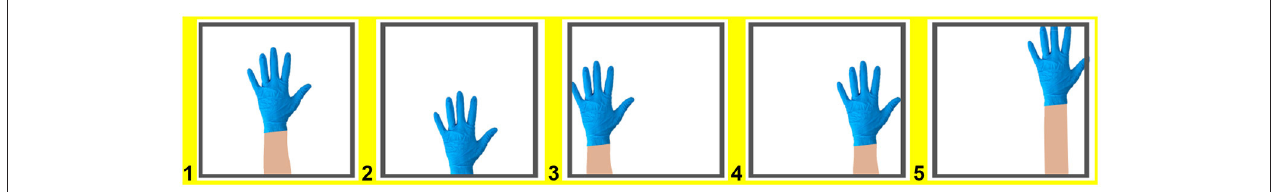
FIGURE 4 | Hand Listener: commands issued to the drone via hand gestures. The offset of the hand with respect to the center indicates the planar direction toward which the drone has to move. The five hand position examples in the figure indicate that the drone should move respectively: forward (1), backward (2), rightward (3), leftward (4), and forward-leftward (5).